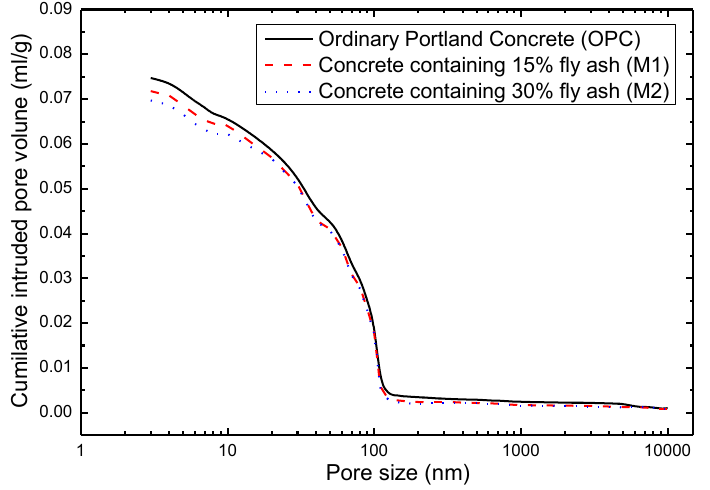
Figure 3. Cumulative mercury porosimetry of all specimens exposed to deionised water.